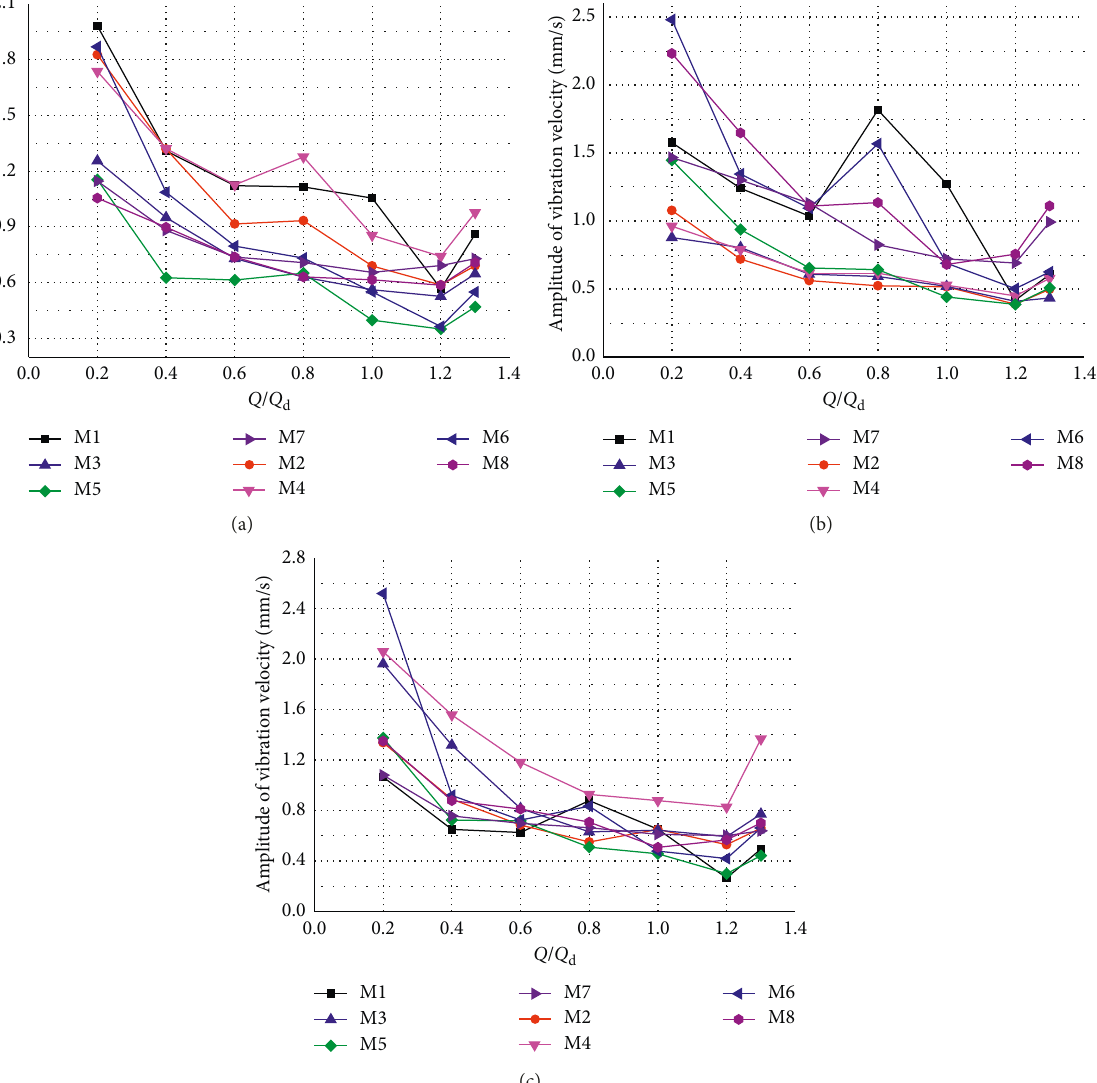
Figure 6: Amplitudes of vibration velocity at M1 ∼ M8 in the (a) X direction, (b) Y direction, and (c) Z